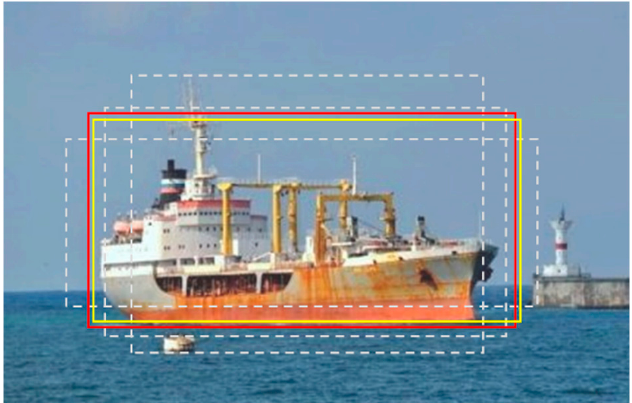
Figure 3. Schematic diagram of the weighted fusion boxes (Yellow box is the real target box, white box for prediction box, and red box is weighted fusion box).